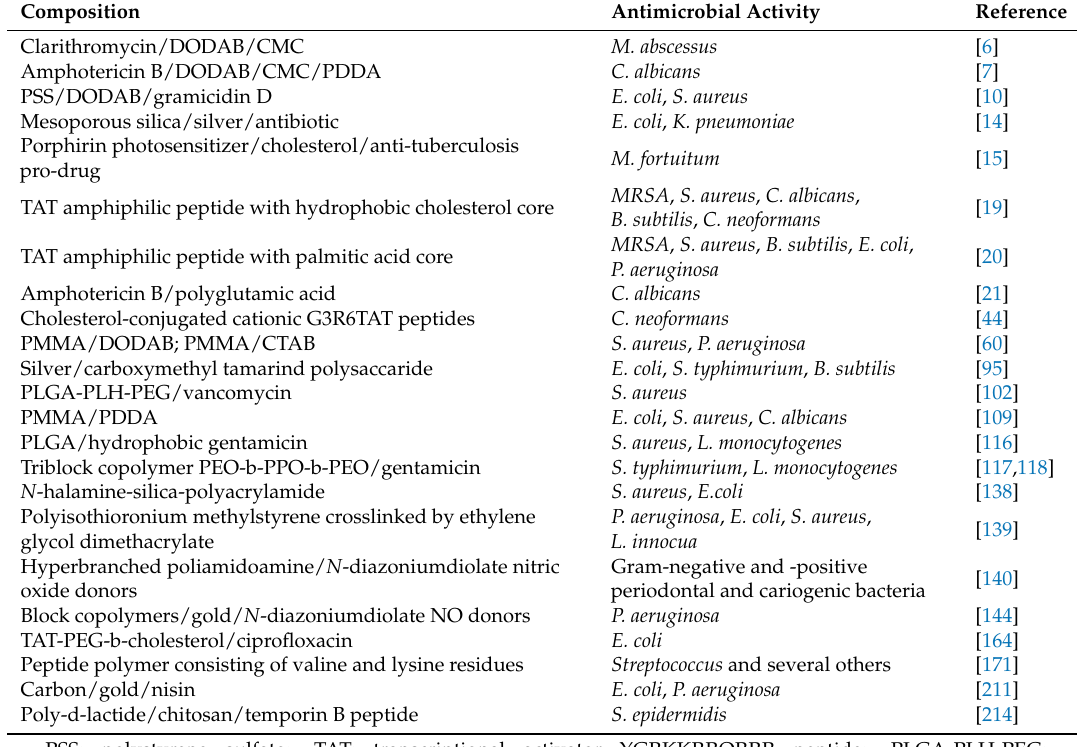
Table 4. Self-assembled nanoparticles: composition and antimicrobial